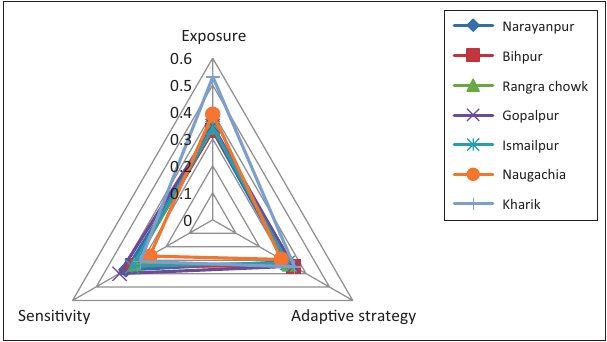
FIGURE 6: Vulnerability triangle diagram of the contributing factors of the Intergovernmental Panel on Climate Change livelihood vulnerability index (livelihood vulnerability index-Intergovernmental Panel on Climate Change) for district